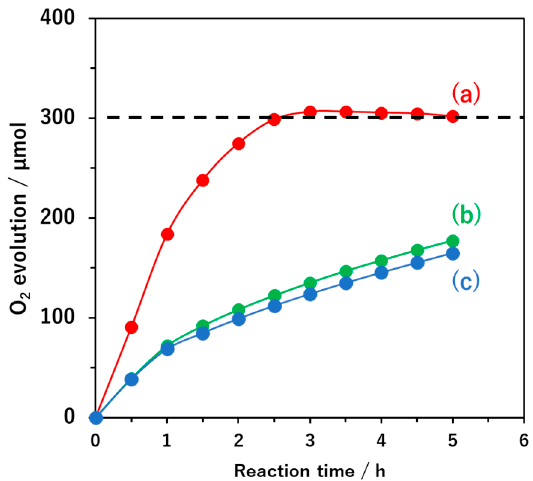
Figure 2. O 2 evolution from aqueous AgNO 3 solutions over time when using FeO x /Pt/BaTaO 2 N:Mg on which FeO x was photodeposited ( a ) using FeCl 2 under ambient air, ( b ) using FeCl 3 under ambient air, and ( c ) using FeCl 2 in the absence of air. The horizontal black dashed line indicates the stoichiometric amount of O 2 that could be evolved from the amount of AgNO 3 added to the solution. Reaction conditions are as follows: BaTaO 2 N:Mg, 0.2 g; Pt, 0.1 wt% loaded by impregnation–reduction; FeO x , 0.1 wt% loaded by photodeposition; distilled water 120 mL; AgNO 3 10 mM; La 2 O 3 as a buffer 0.1 g; 300 W Xe lamp ( λ > 420 nm).